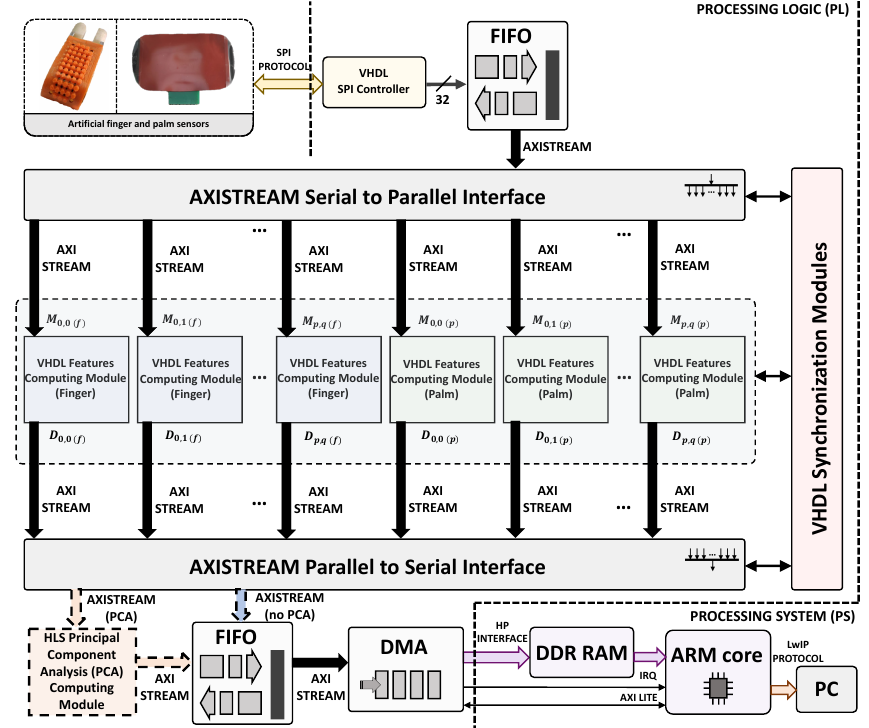
Figure 7. General architecture of the implementation on the Zynq-7000 XC7Z020 ® . The dashed part in orange is implemented if PCA is applied.